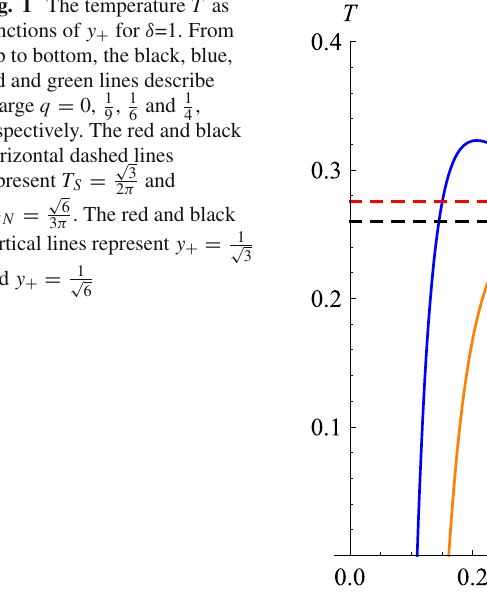
q = 0, the intersection of the red horizontal and the vertical